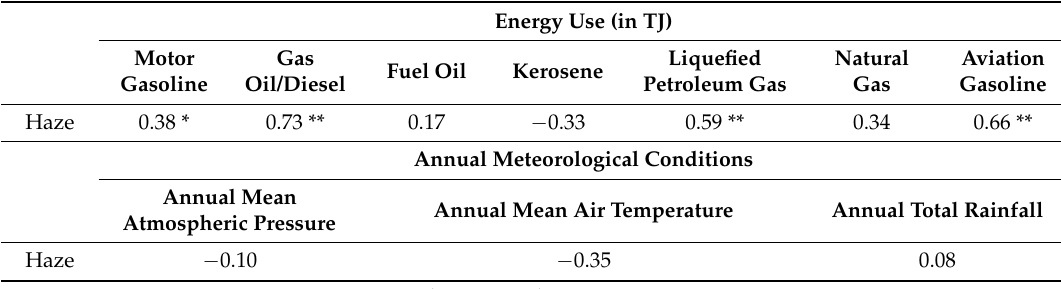
Table 3. Correlations between haze, energy consumption, and meteorological